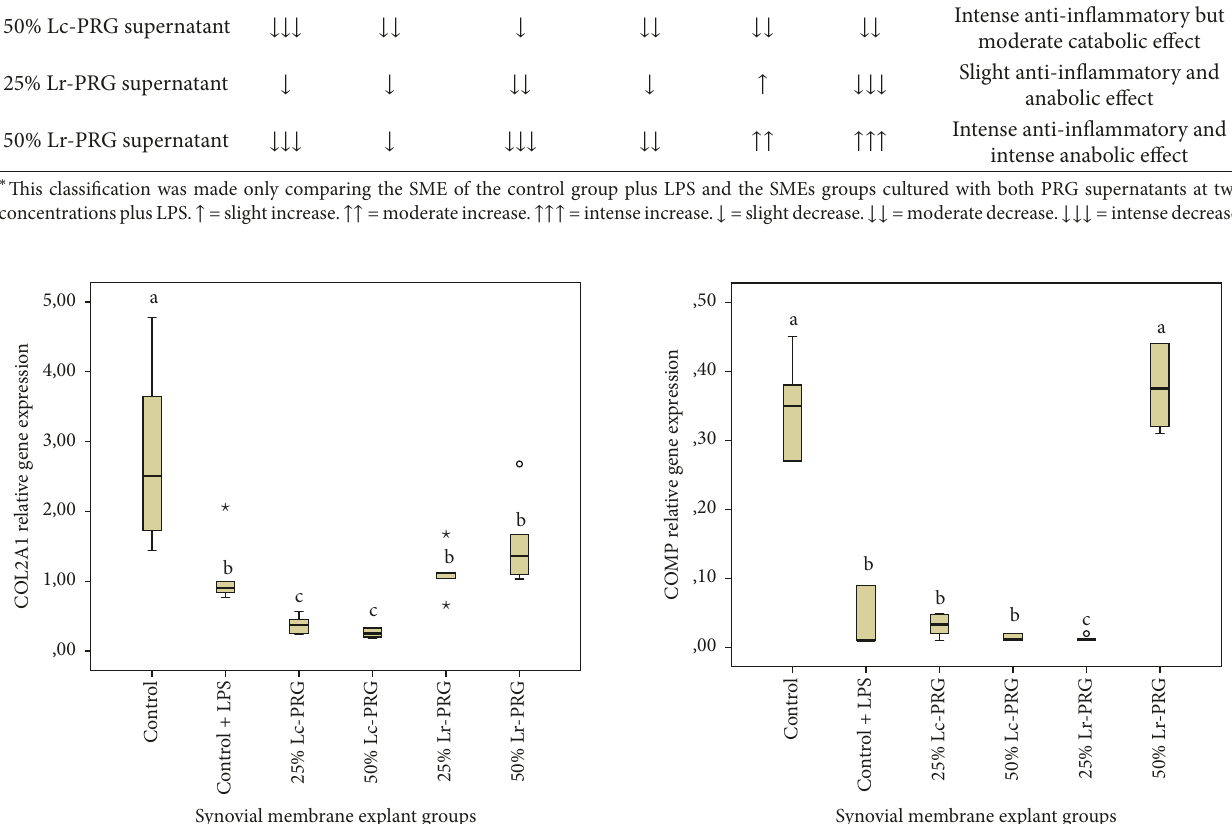
Figure 6: Box plot of median relative collagen type II alpha 1 (COL2A1) gene expression. a–c Lowercase letters denote significant differences (𝑝 > 0.05) between SME groups treated with Lc-PRG and Lr-PRG supernatants at different concentrations (25 and 50%). Groups with the same lowercase letter are not significantly different. ∘ denotes an outlier value, whereas ⋆ denotes extreme value; both symbols show nonparametric data.